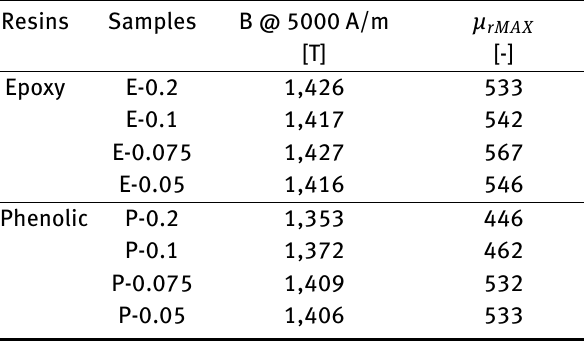
Table 1: Magnetic induction B @ 5000 A/m and Maximum magnetic permeability for both typologies of samples Resins